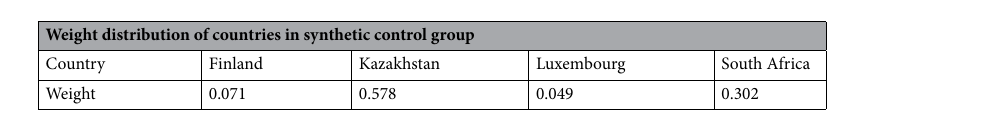
Table 7. Weight distribution of countries in synthetic control group (Carbon emission intensity).